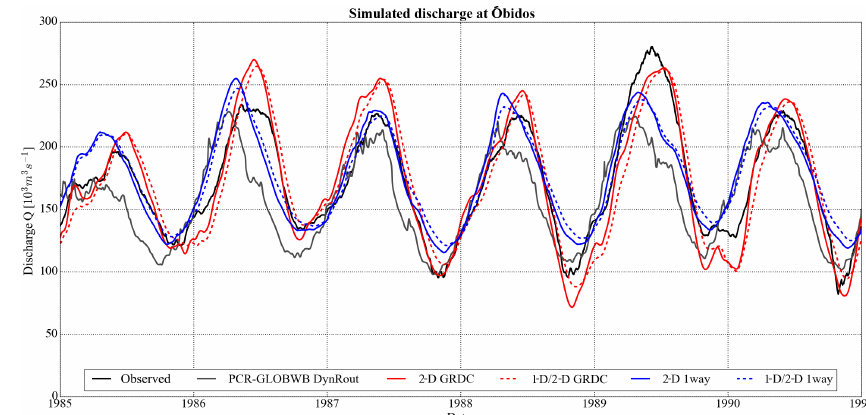
Figure 5. Plot of all model results and observed discharge values at GRDC station Óbidos.